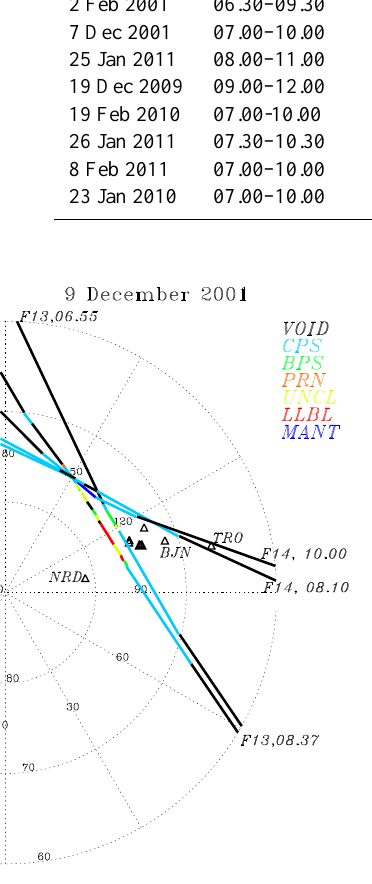
Figure 9. The superposition of the DMSP-identified boundary do- main projections in the dayside hemisphere and station locations during the period of cusp observations by radar, from 07:00 to 10:00UT 9 December 2001 (in polar geomagnetic coordinates). The station with maximal ULF power is highlighted by a solid tri-